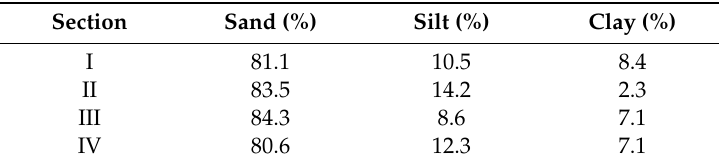
Table 4. The textural properties of the sediment